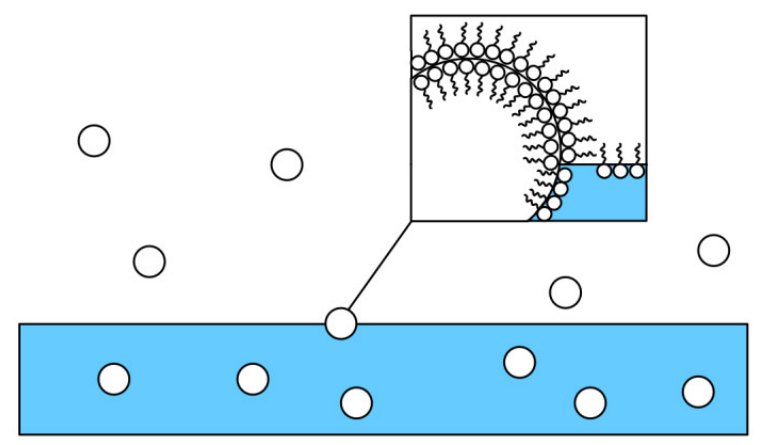
Figure 19. Visualization images of the foam inside the chamber at different CTAB concentrations: